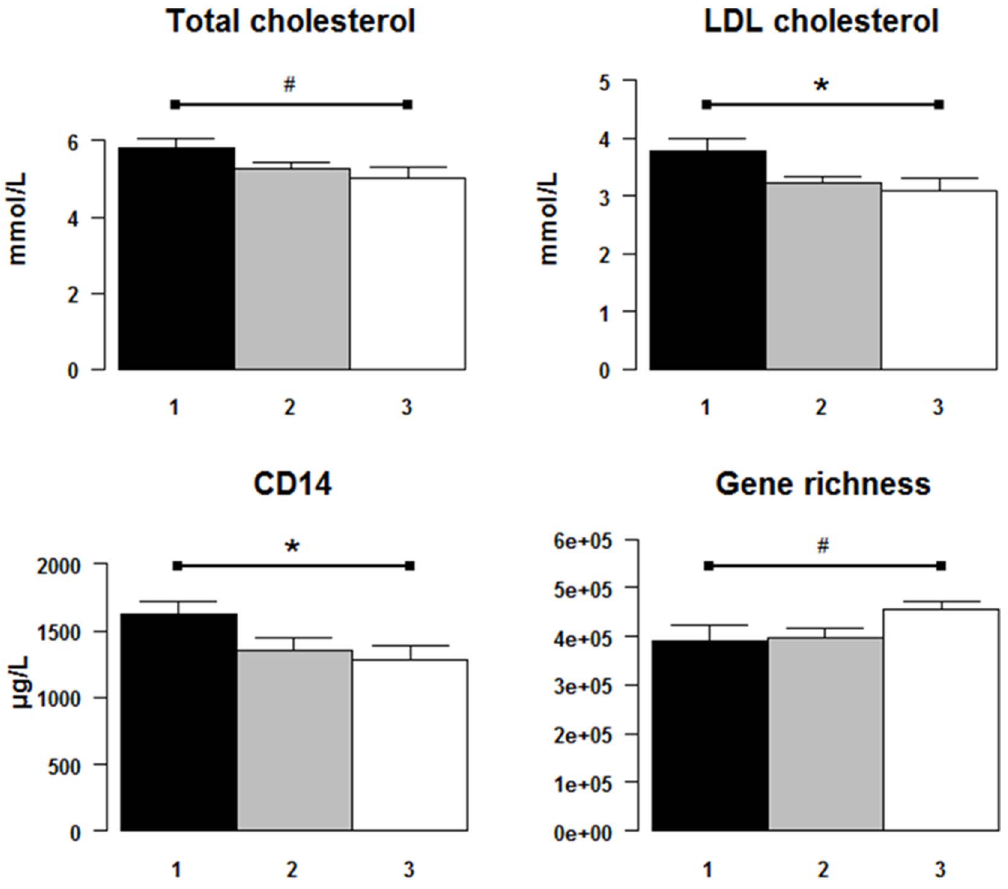
Figure 3. Differences of metabolic and inflammatory markers after stratified Kruskal-Wallis tests in the 3 dietary pattern clusters. Black, grey and white columns represent the median values of the parameters in Cluster 1, Cluster 2 and Cluster 3, respectively, after age adjustment (see Methods S1 in Supporting Information S1). *: significant differences (p # 0.05) between the 3 clusters after stratified Kruskal-Wallis tests, # : a tendency of differences (0.05 , p , 0.15) between the 3